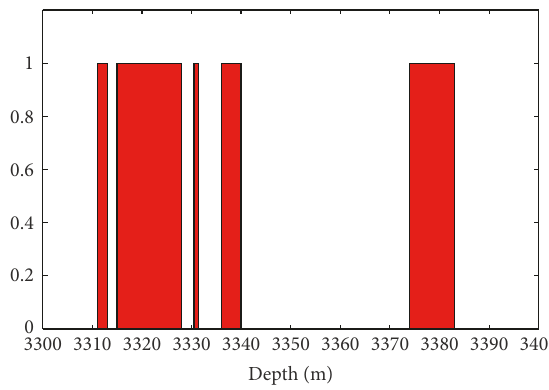
Figure 3: The actual gas distribution.